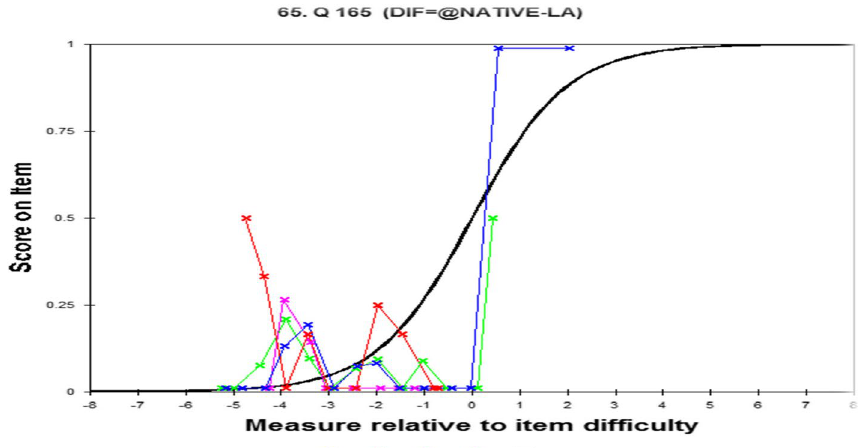
Fig. 1 Item characteristic curves of Item 65 by native language (color figure available online). Note : (1) Blue Azeri. (2) Red Kurdish. (3) Violet Lori. (4) Green = = =